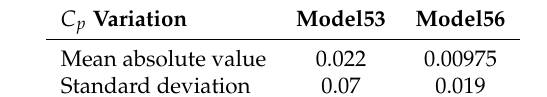
Table 2. Mean absolute and standard deviation values of the C p variation of consecutive measurements of Models 53 and 56.